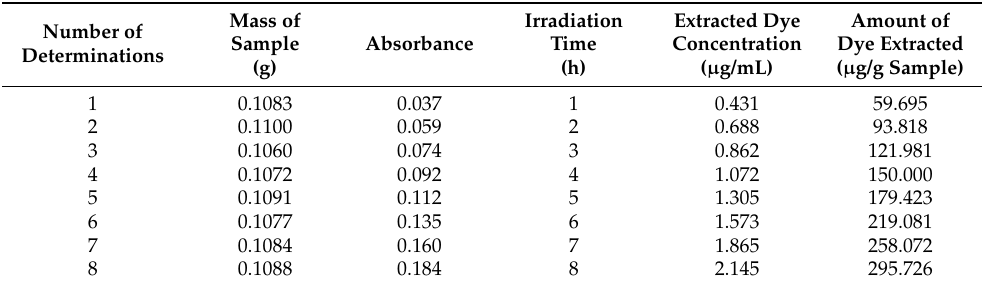
Table 8. Dependence of absorbents on irradiation duration and 5% concentration of dye extracted from dyed cotton in an acid